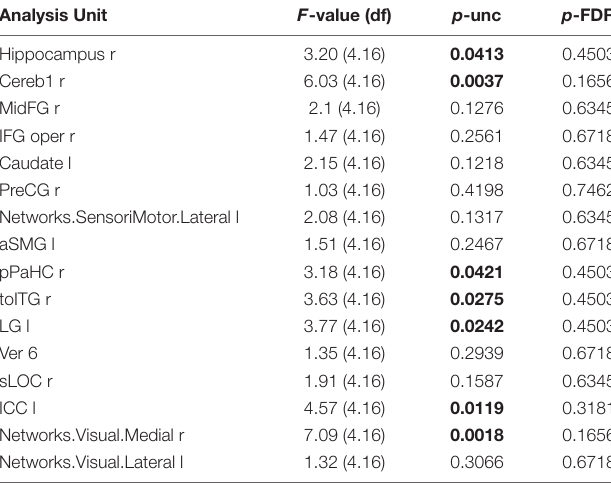
TABLE 4 | Post-training > pretraining connectivity